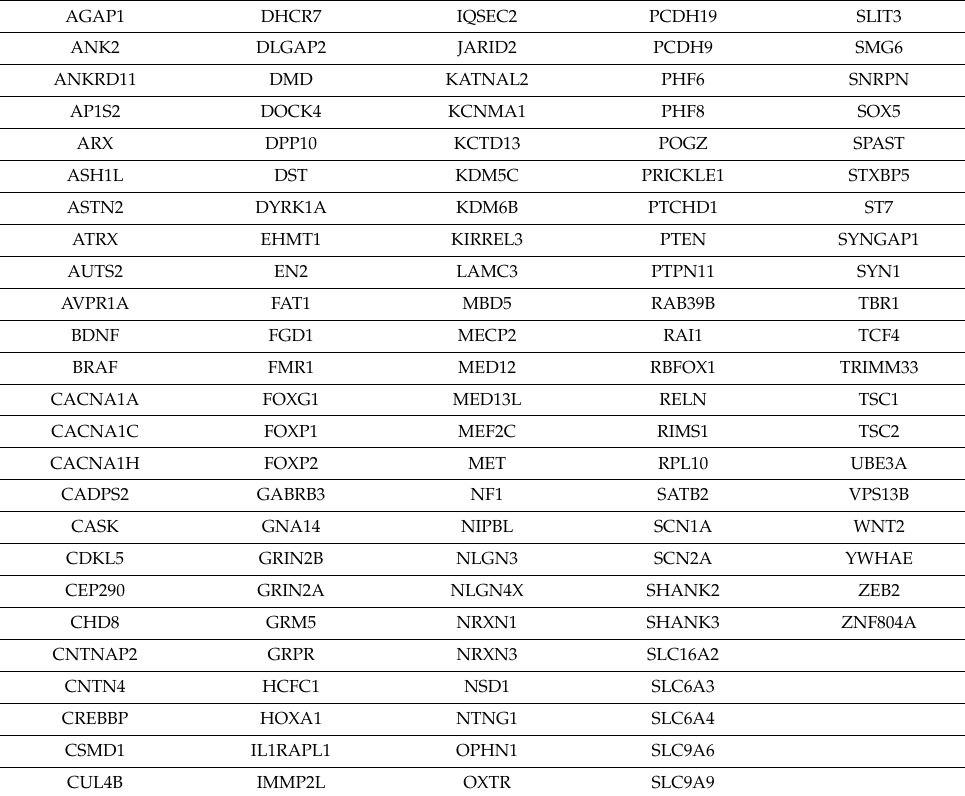
Table 1. List of 120 genes included in the NGS